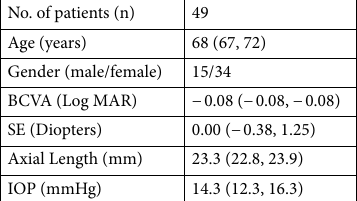
Table 1. Participant characteristics. Data are presented as numbers or median (interquartile range). LogMAR represents the log of the decimal best corrected visual acuity. LogMAR logarithm of the minimum angle of resolution, SE spherical equivalent, IOP intra ocular